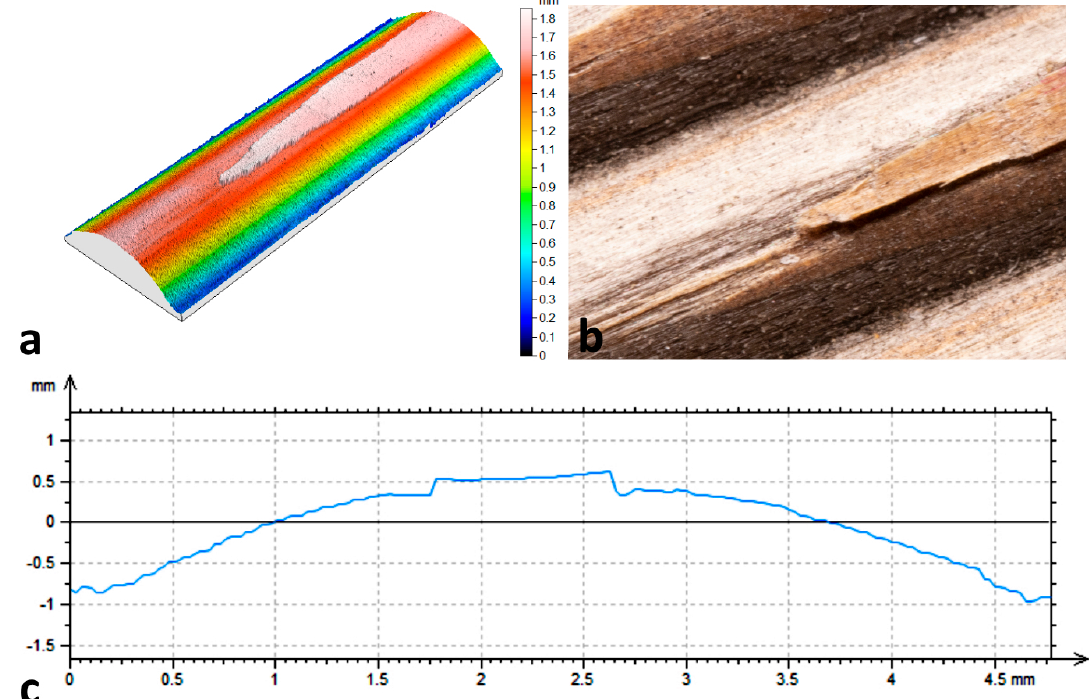
Figure 7. Shelling of a growth ring tip on the peak of a profiled (rib) western larch deckboard with growth rings oriented pith-side-up and exposed to the weather for seven months in Vancouver, Canada: ( a ) confocal profilometry height map of a shelled latewood tip; ( b ) photograph of a shelled latewood tip matching the image in Figure 7a; and, ( c ) confocal profilometry line trace showing variation in height of the latewood tip in Figure 7b.